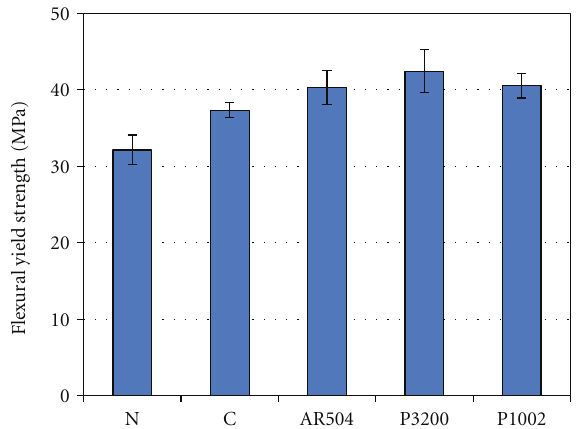
Figure 3: Comparison of flexural strength experienced at 5% strain for neat and sunflower hull-reinforced polypropylenes with and without the inclusion of chemical